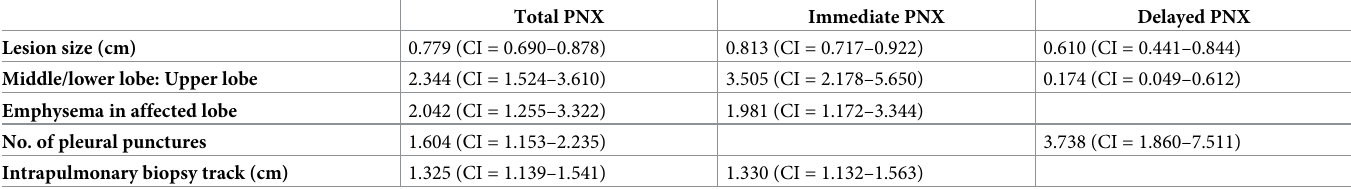
Table 3. Multivariate analysis of risk factors for development of